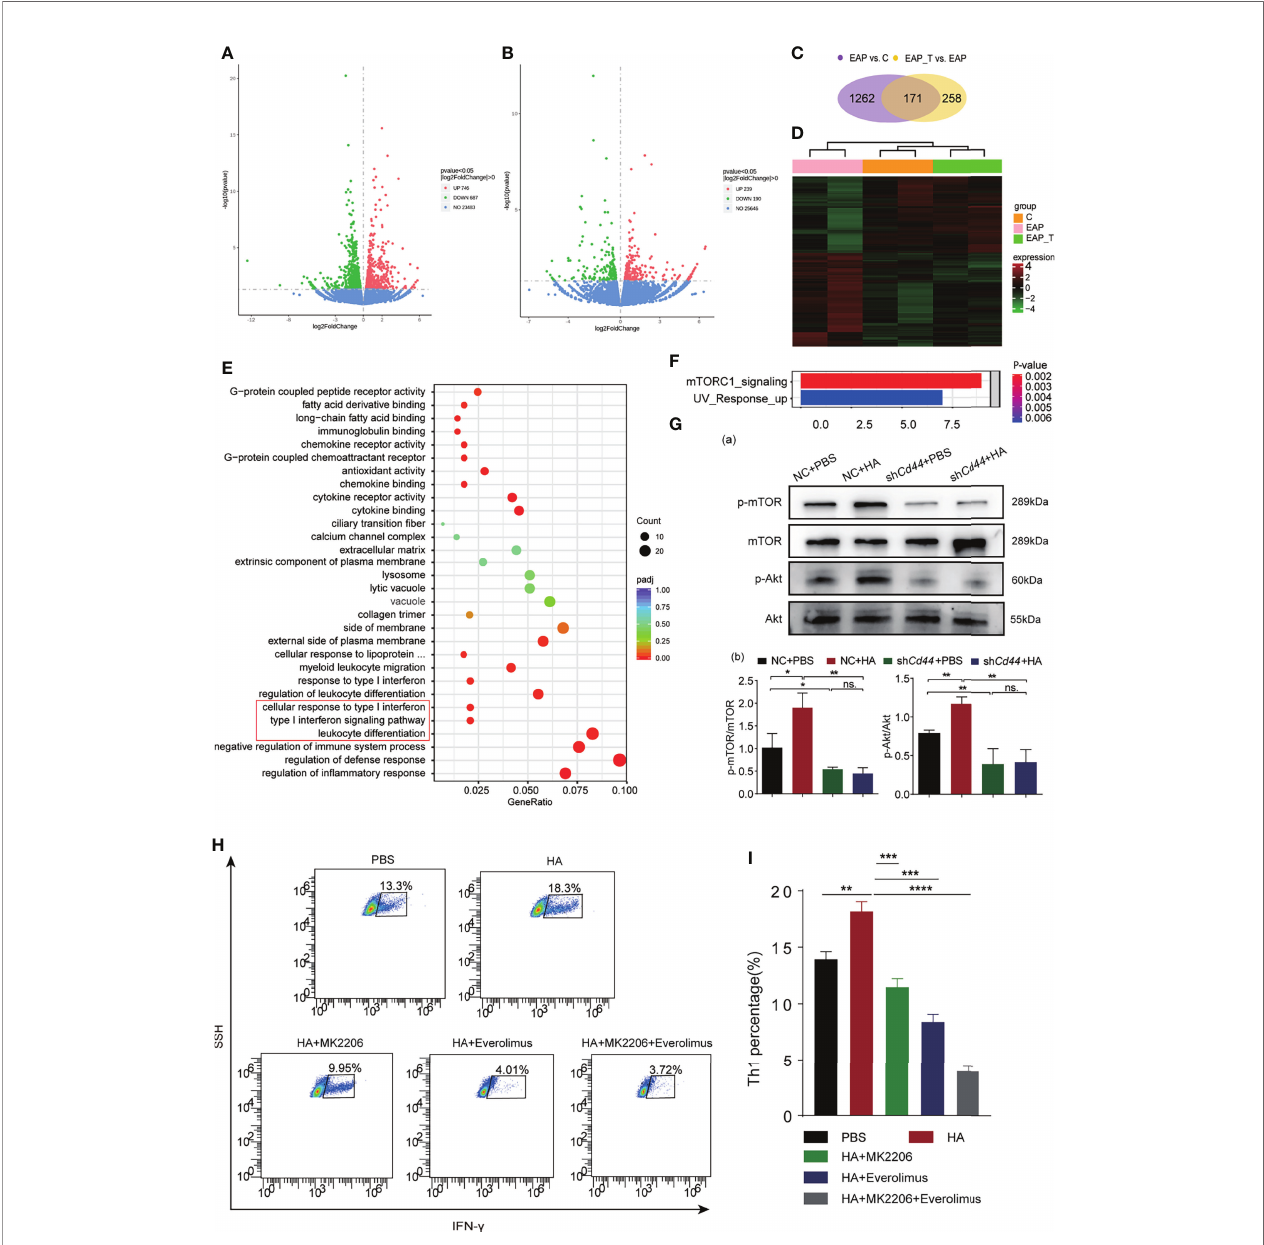
FIGURE 4 | HA/CD44 axis activated the Akt/mTOR pathway to promote Th1 cells differentiation. (A) Differentially expressed genes of Th1 cells from NOD mice among the Ctrl + DMSO and EAP + DMSO groups. (B) Differentially expressed genes of Th1 cells from NOD mice among the EAP + DMSO and EAP + 4-MU groups. (C) Mutual differentially expressed genes among EAP + DMSO vs. Ctrl + DMSO and EAP + 4-MU vs. EAP + DMSO. (D) Heatmap of Th1 cells from NOD mice among the Ctrl + DMSO, EAP + DMSO, and EAP + 4-MU groups. (E) The differential genes enriched pathways by the analysis of GO. (F) The differential genes enriched pathways by the analysis of KEGG. (G) The expression levels of p-mTOR, mTOR, p-Akt, and Akt of Th1 cells in the in vitro differentiation experiment among NC + PBS, NC + HA, sh Cd44 + PBS, and sh Cd44 + HA groups. (H) The differentiation ratio of Th1 cells in the in vitro differentiation experiment among PBS, HA, HA + MK2206, HA + Everolimus, and HA + MK2206 + Everolimus groups by fl ow cytometry. (I) Corresponding data analysis according to data in (H) . ns, Not Signi fi cant. ****p < 0.0001, ***p < 0.001, **p < 0.01, *p <